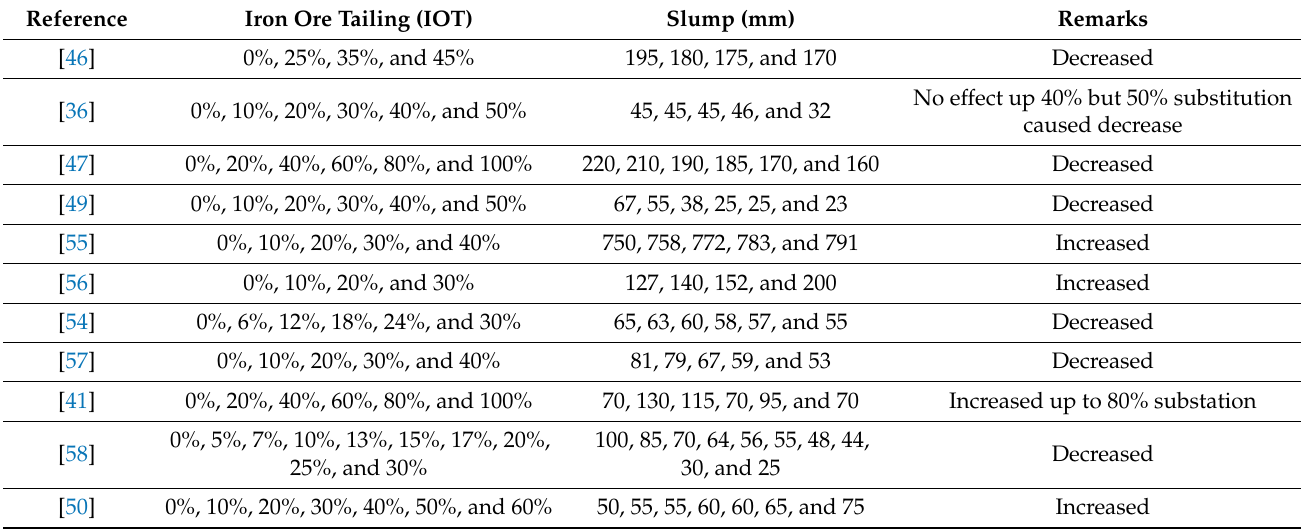
Table 2. Summary of slump